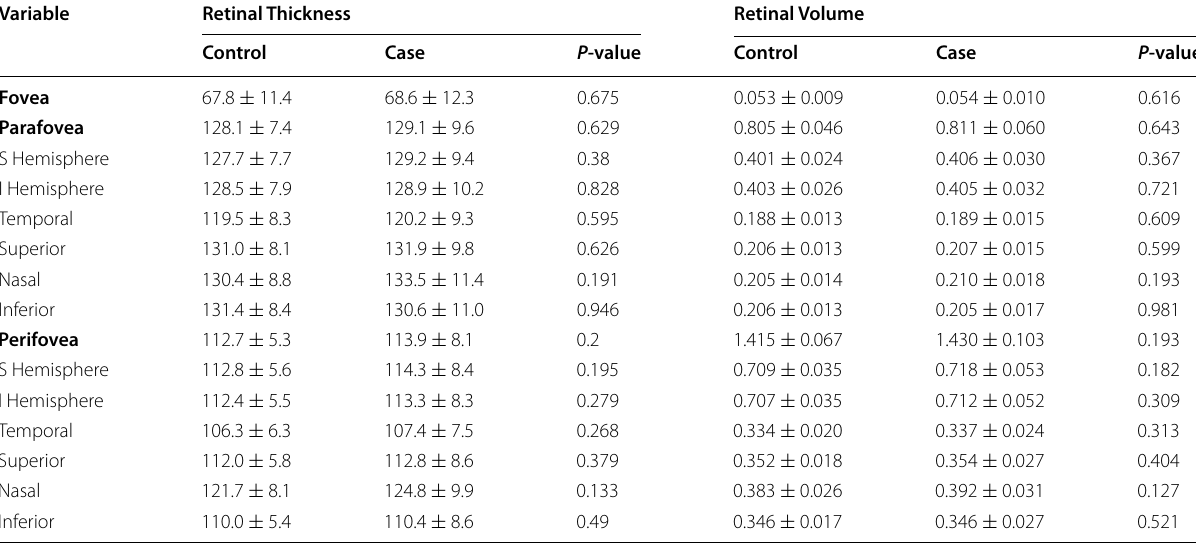
25) and Control Group ( N = =